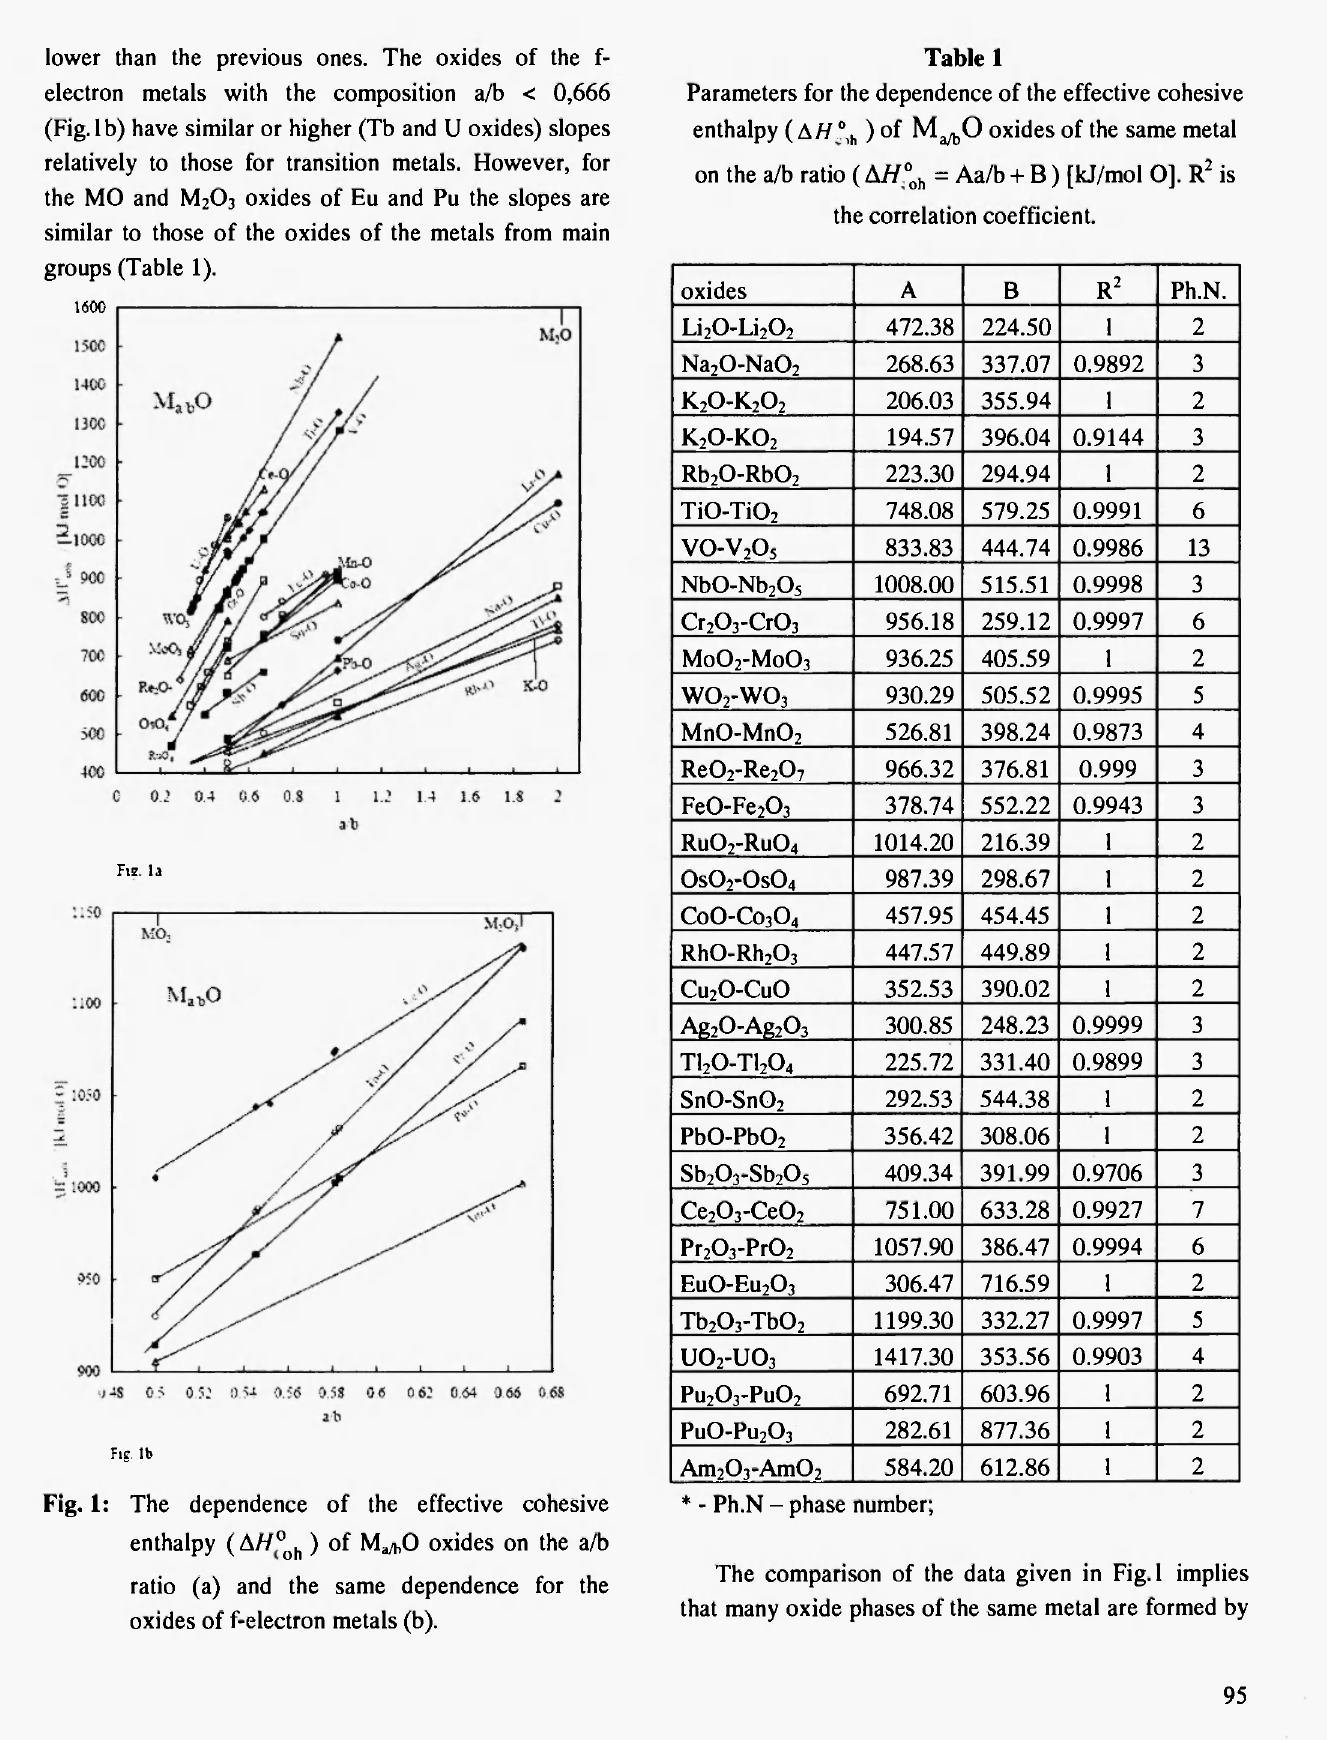
Fig. 1: The dependence of the effective cohesive enthalpy (A//° oh ) of M ^O oxides on the a/b ratio (a) and the same dependence for the oxides of f-electron metals (b).